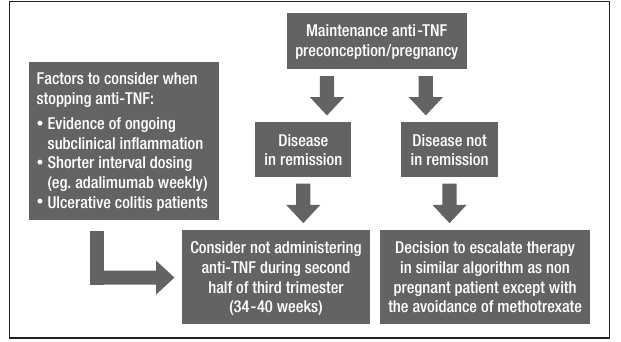
Figure 3) Algorithm for management of patients on maintenance antitumour necrosis factor (anti-TNF) therapy